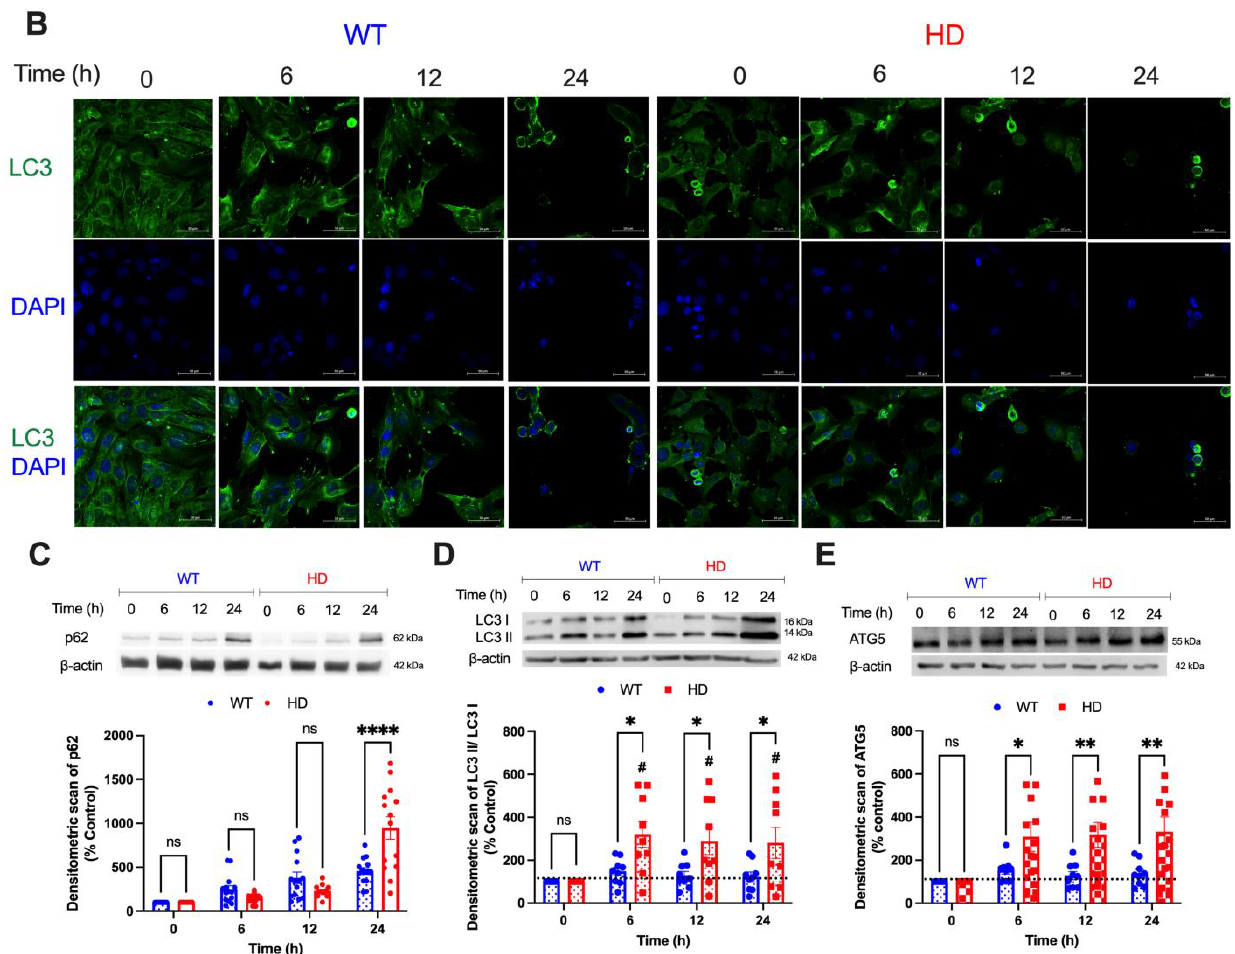
Figure 5. Cd upregulates autophagy-related proteins in HD striatal cells. Representative confocal images of ( A ), p62 (red), ( B ), LC3 (green), and DAPI (blue) expression in WT and HD cells upon 40 µM CdCl 2 exposure at the indicated time points. Scale bar: 50 µm. Representative immunoblotting and quantification of ( C ) p62, ( D ) LC3-II/I, and ( E ) ATG5 in WT and HD striatal cells after 40 µM CdCl 2 at the indicated time points. Quantitative immunoblotting data is represented as percent expression relative to the respective control within each genotype. Results are represented by the mean ± SEM from nine to fourteen biological replicates (N = 9–14). Sidak’s multiple comparison test compared the effect of Cd on endogenous p62, LC3, and ATG5 expression between genotypes at the indicated time points (significant differences: * p < 0.05, ** p < 0.01, and **** p < 0.001 for C – E ). # indicates statistical significance ( p < 0.05) compared with the respective negative controls. Images at 63 ×